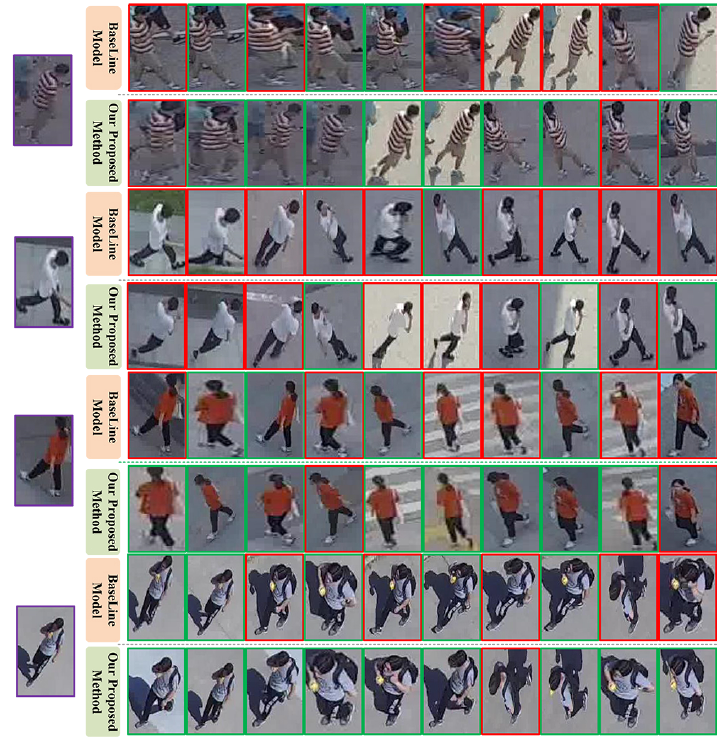
Figure 10. Parts of visual object Re-ID results on the PRAI-1581 using the baseline module and the HP-SET-Attn configuration of the proposed AAD-CPGE